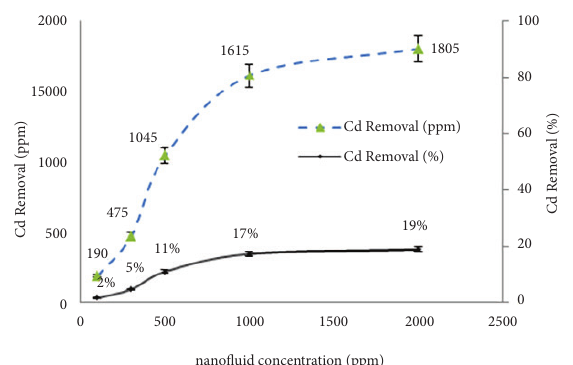
Figure 3. Removal of Cd by nanofluid at different concentrations (pH = 8.5, ratio of soil mass (gr) to nanofluid volume (mL) = 1:10, Contact time = 24 hr)